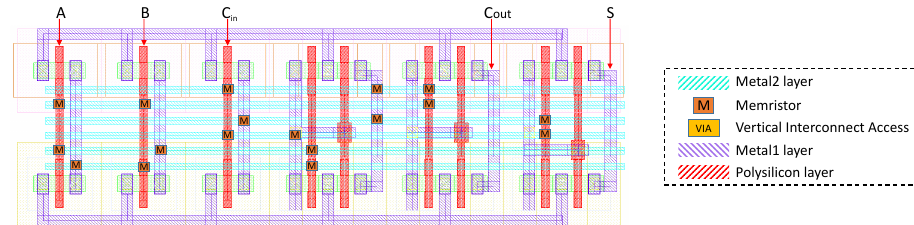
Figure 9. Proposed layout for the hybrid memristor–CMOS 1-bit full adder based on the X-MRL design technique.